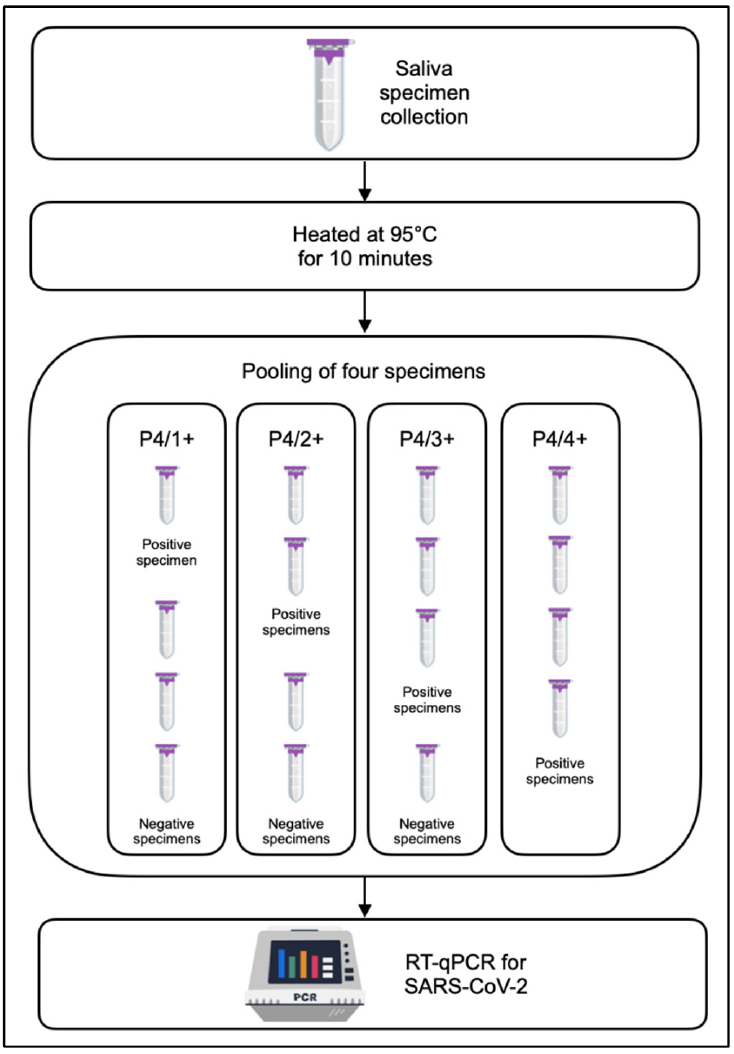
Figure 1. Schematic workflow of pooling of four specimens. Saliva specimens were collected and subjected to inactivation during heating. Three negative specimens and one positive specimen (P4/1+) were pooled, followed by RT-qPCR to detect SARS-CoV-2. The other pooling schemes are P4/2+, P4/3+, and P4/4+, which consist of two, three, and four positive saliva specimens, respectively, that were carried out accordingly prior to detection.